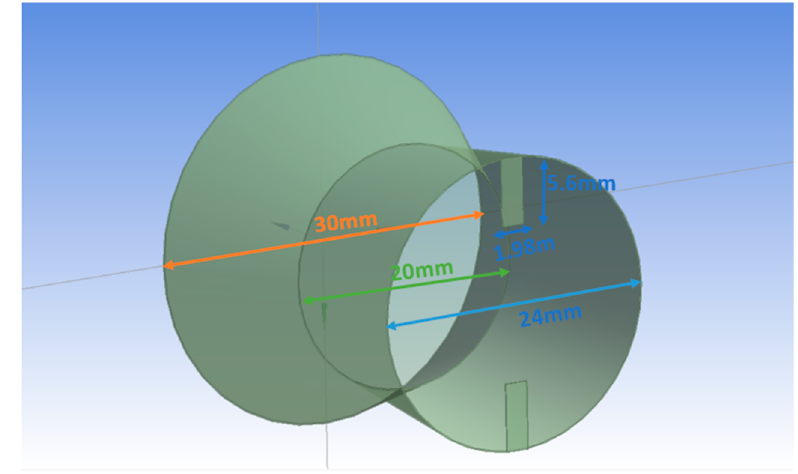
Figure 1. Mach 1.8 convergent-divergent nozzle with short rectangular tabs employed at the nozzle exit.